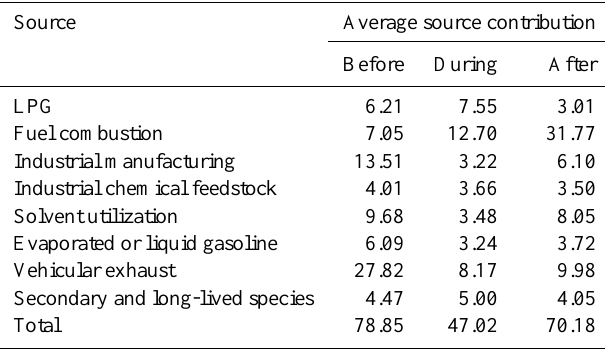
Table 4. Source contributions (ppbv) derived by PMF